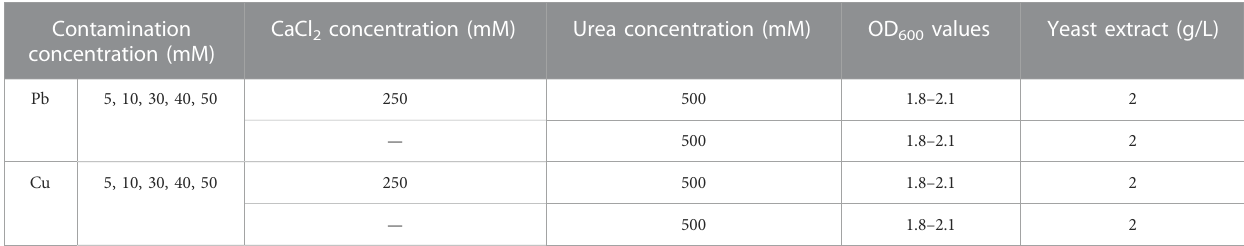
TABLE 1 Testing scheme applied to Pb and Cu remediation using